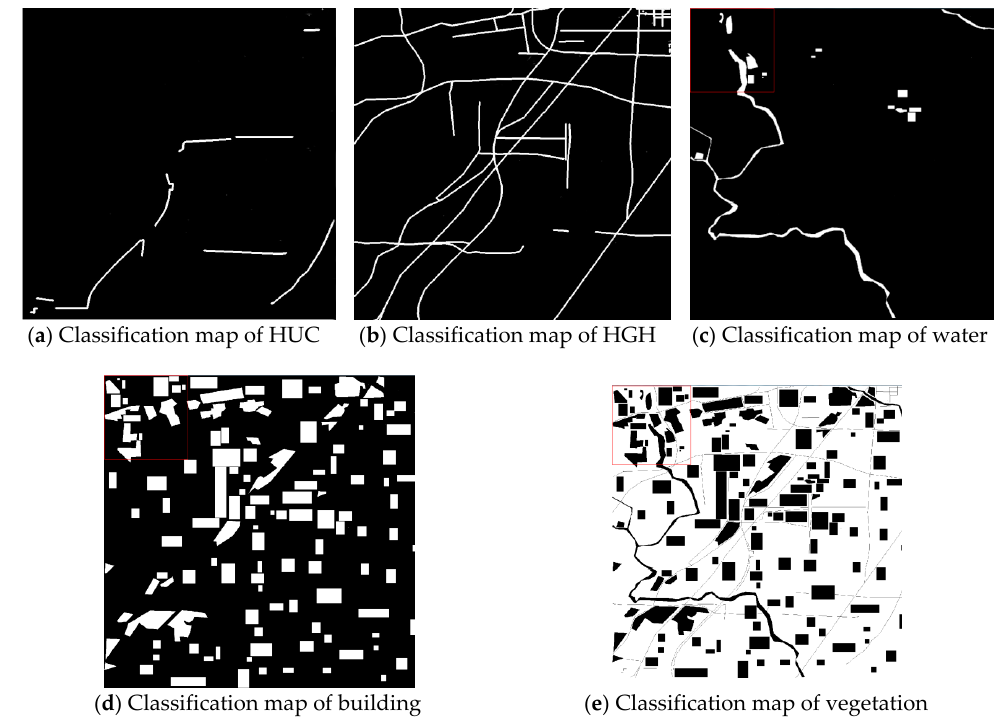
Figure 2. Classification maps of the study area.